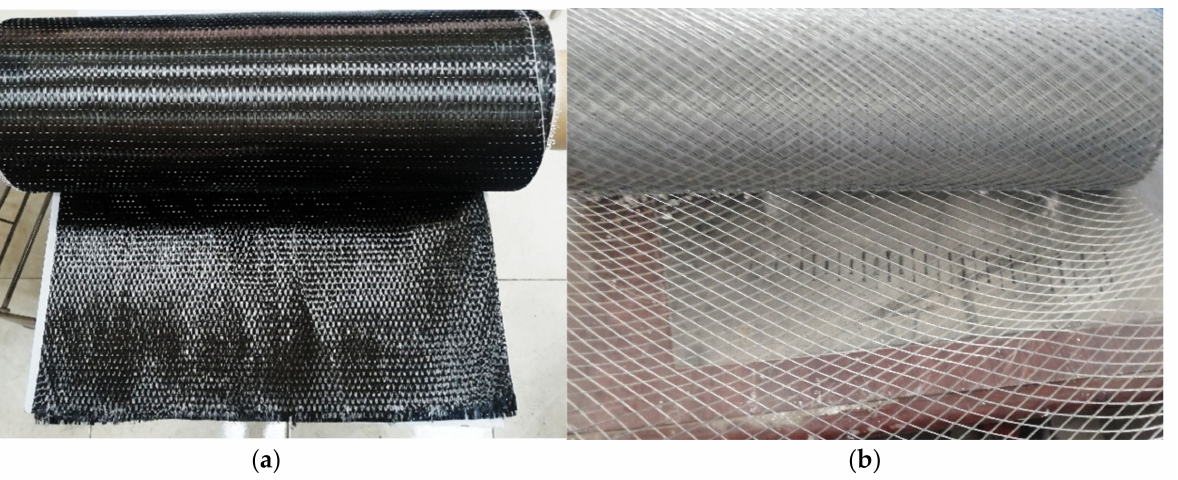
Figure 2. Sieve analysis for the natural aggregates and crumb rubber. The CFRP laminates and WWM were used to strengthen the RC columns externally and internally, respectively. The CFRP laminates (Nitowrap CWS 530, Figure 3a) with a thickness of 0.239 mm were used to confine the RC columns. The properties of the CFRP laminates are summarized in Table 2 (from the supplier data sheet). The CFRP was bonded to the RC columns using epoxy resin (Nitowrap Encapsulation Resin) with the properties reported in Table 2. The WWM had 1.1 mm × 2.0 mm openings and 0.6 mm wire diameter (Figure 2). According to ACI-549 [47], the steel of the WWM had yield and tensile strengths of 360 and 420 Mpa, respectively, and 190 Gpa young’s modulus (from the supplier data sheet).